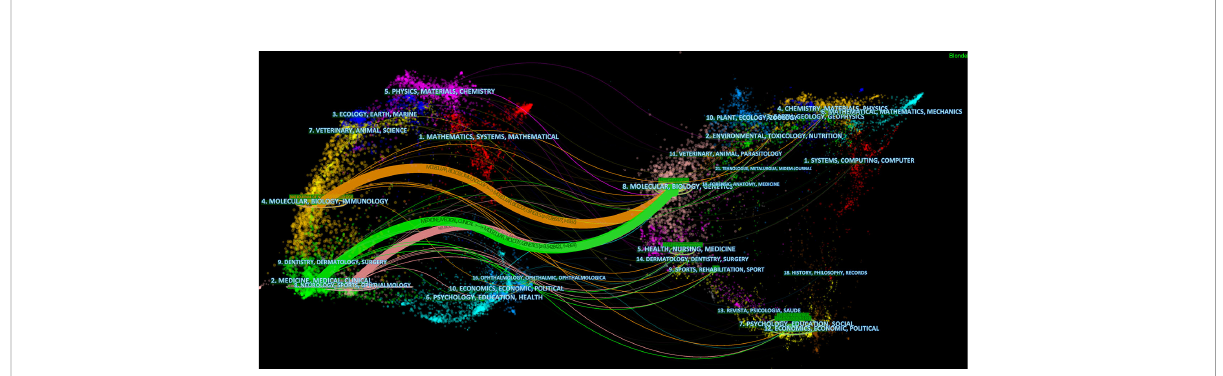
FIGURE 7 The dual-map overlay of academic journals in the fi eld of targeted immunotherapy for MG based on the CiteSpace software. The labels represent different research subjects covered by the journals. The citing journals are on the left side, while the other side of the map represents the cited journals. Different colored lines correspond to the different paths of references, beginning with the citing map and ending at the cited map. The path widths are scaled proportionally to the frequency of z-score-scale citation.